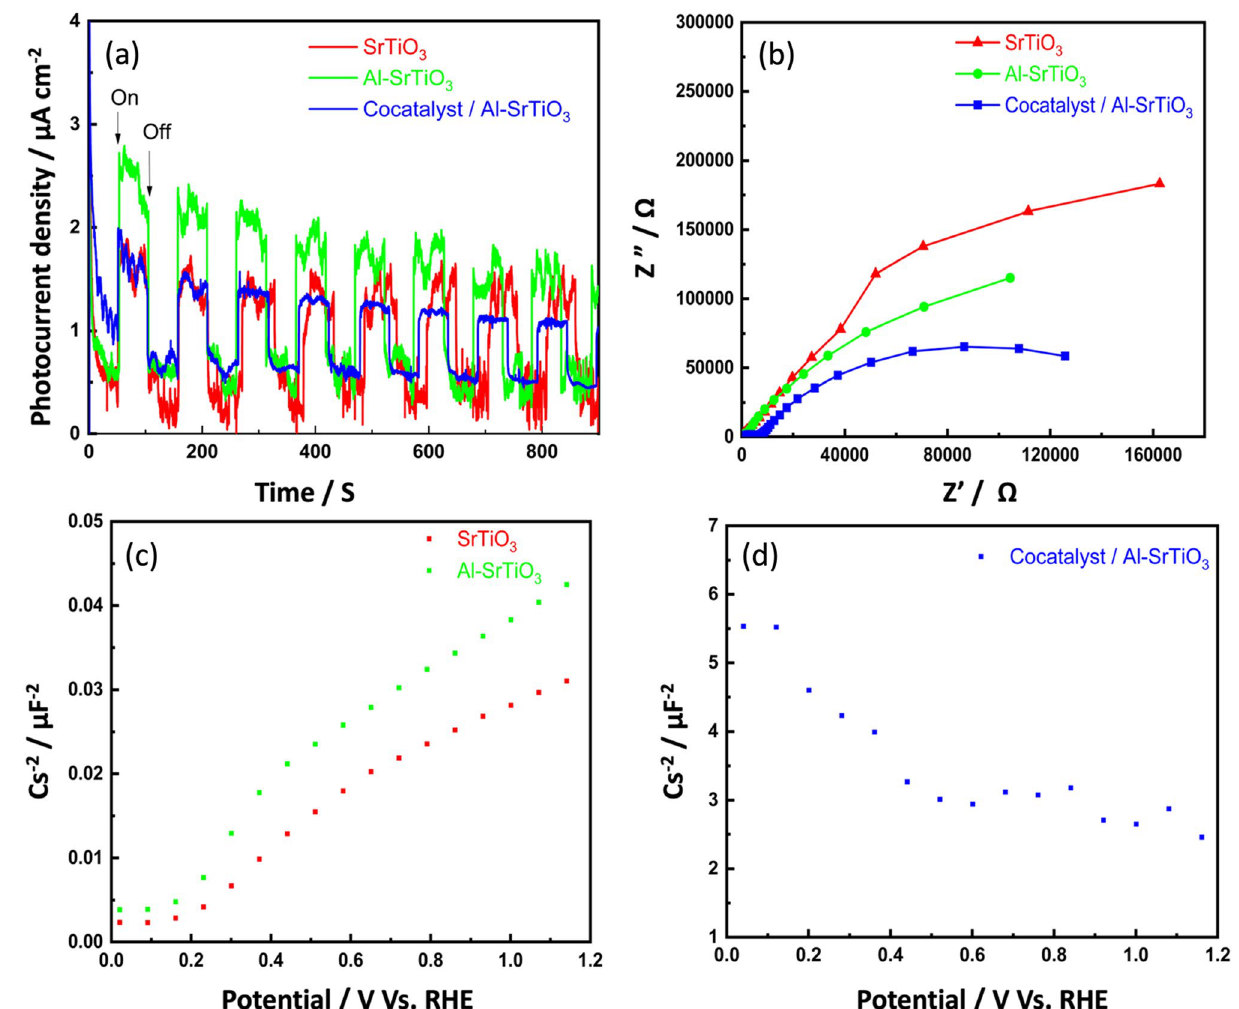
Figure 10. ( a ) Photocurrent response, ( b ) EIS Nyquist curves, and Mott–Schottky plots of ( c ) SrTiO 3 , Al-SrTiO 3 , and ( d ) cocatalyst loaded Al-SrTiO 3